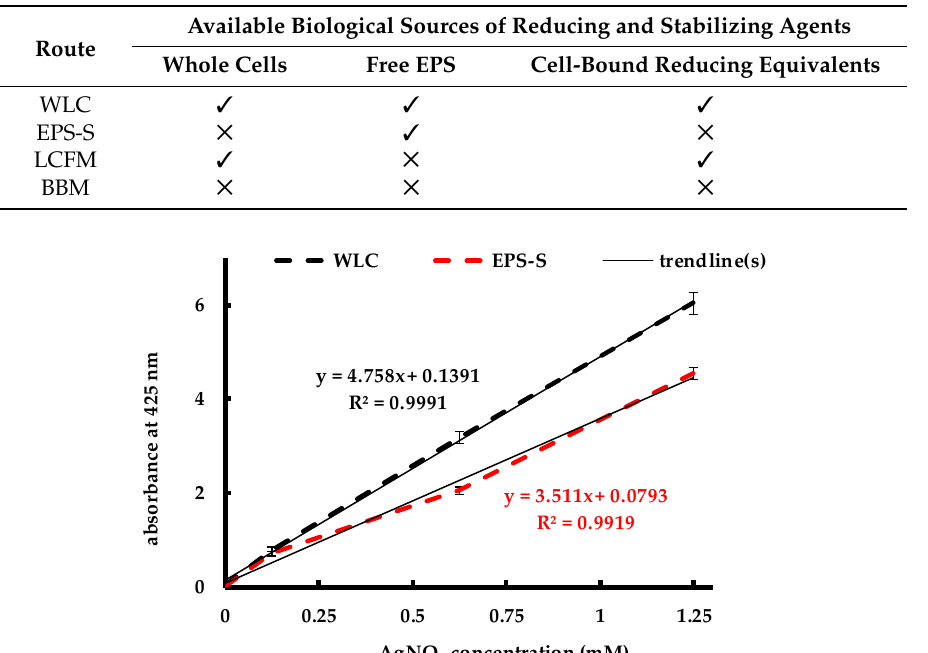
Figure 3. Evolution of AgNP SPR intensity at 425 nm vs. time for WLC, EPS-S and LCFM at AgNO 3 concentrations of: ( a ) 1.250 mM; ( b ) 0.625 mM; and ( c ) 0.125 mM. Table 1. The presence of available biological sources in the different biosynthesis routes.